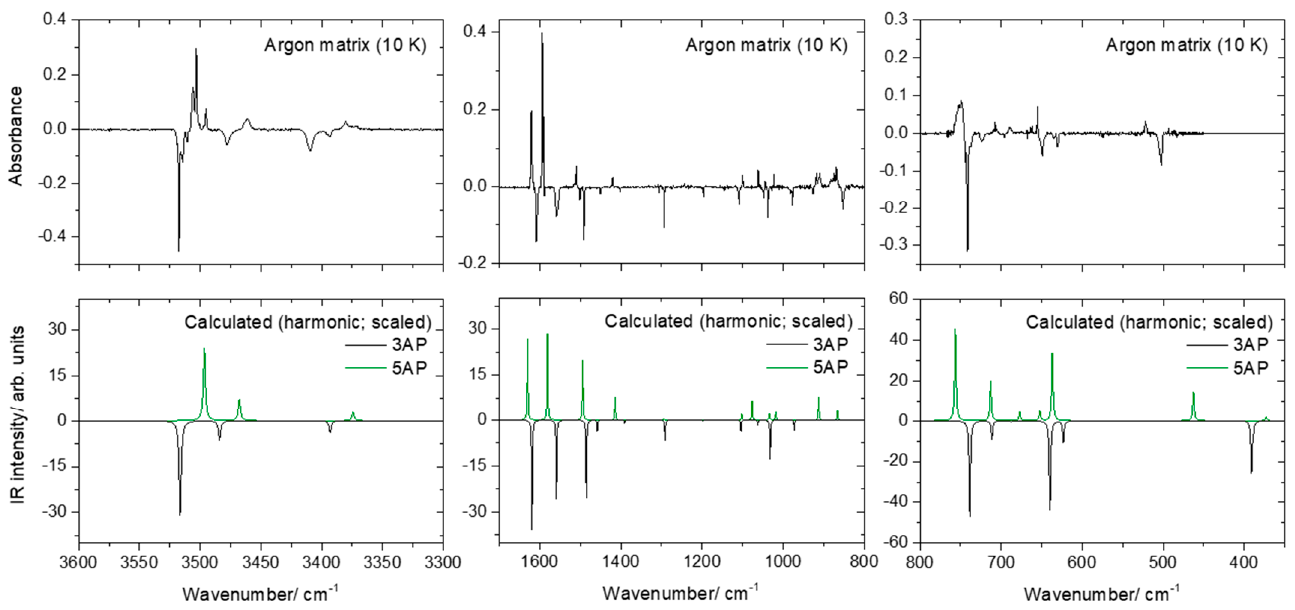
Figure 3. Experimental IR difference spectra obtained by subtracting the spectrum of the as-deposited argon matrix from that obtained after UV irradiation ( λ > 235 nm; 5.5 h; 10 K) in different spectral regions (top panels) and DFT(B3LYP)/6-311++G(d,p) calculated IR spectra of 3AP (black) and 5AP (green) calculated within the harmonic approximation. In the calculated spectra, wavenumbers were scaled, and the intensities in the spectrum of 3AP were multiplied by − 1.